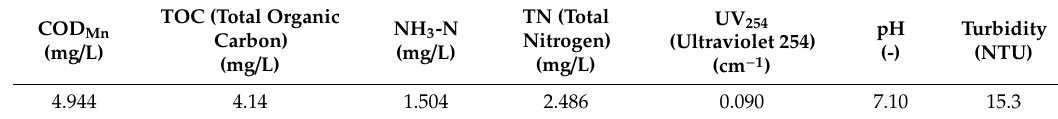
Table 1. Water quality index of Sanhaowu River.